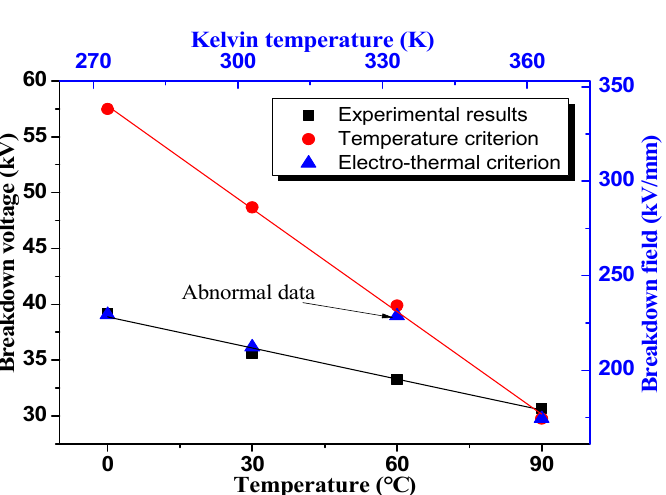
Figure 7. Comparison of electro ‐ thermal breakdown simulations and breakdown experiments. Temperature ‐ and electric field ‐ dependent mobility was considered.